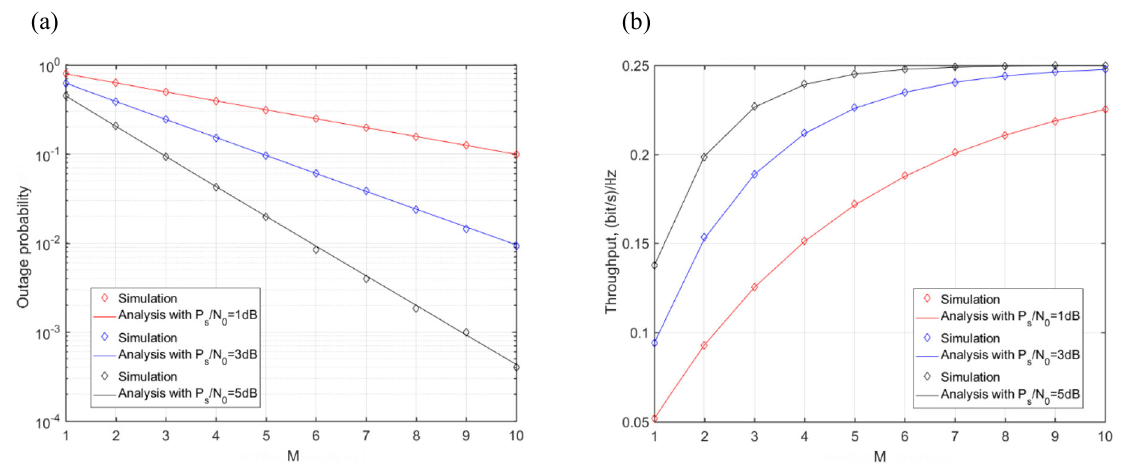
Fig. 5. Outage probability (a) and achievable throughput (b) versus the number of sources M